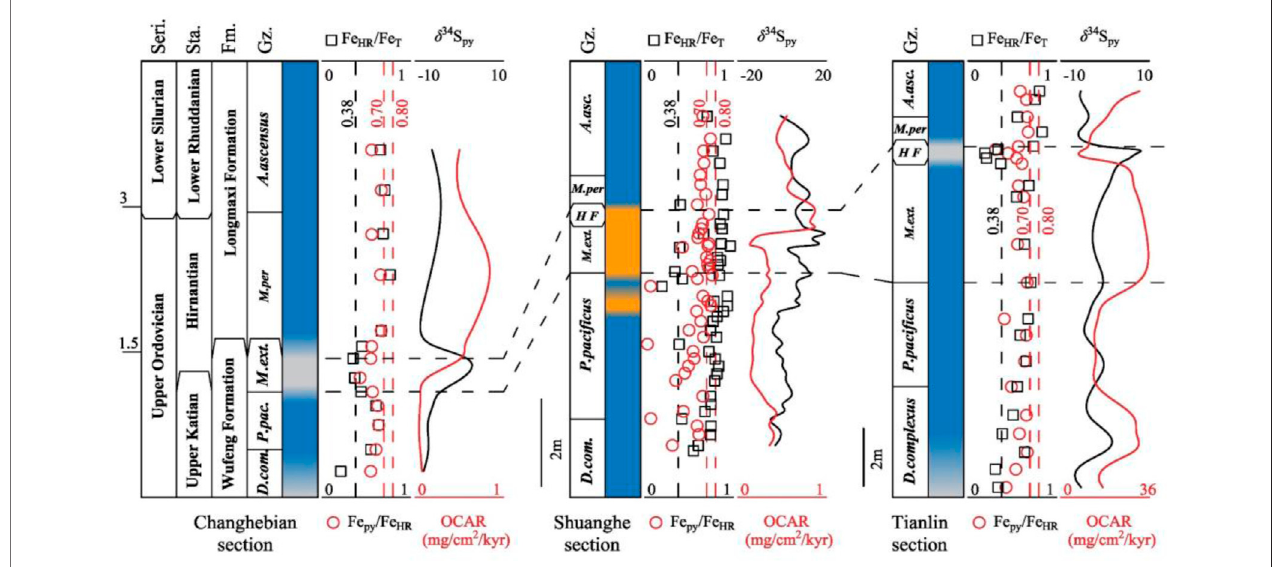
FIGURE 9 | Comparison of the redox condition, δ 34 S py , and OCAR for the three sections. The data of the Shuanghe section are from Liu et al. (2016) and Li et al. (2017). Red and black vertical dashed lines represent thresholds for proxies, as shown in the text.